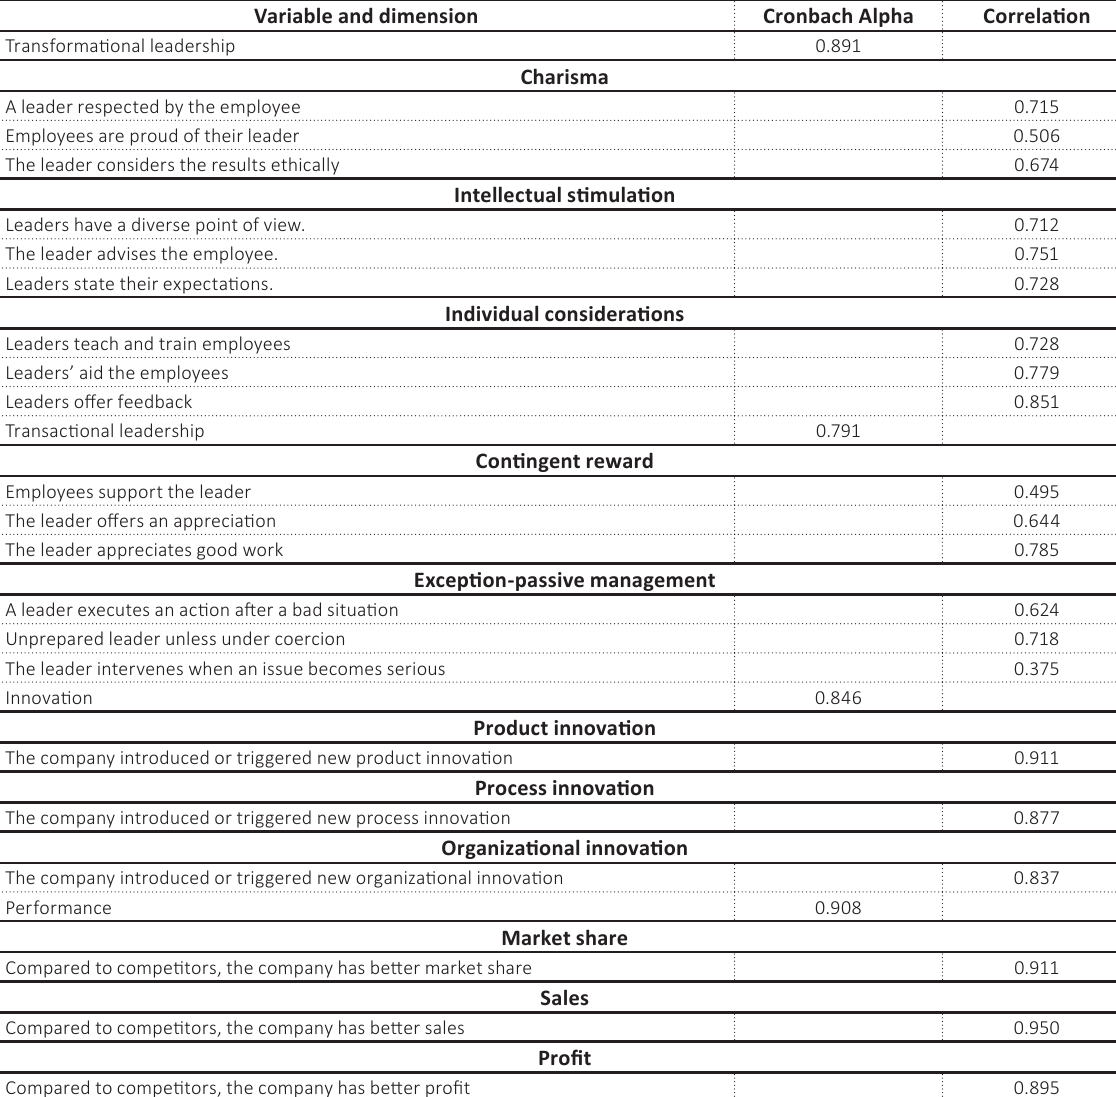
Table 1. The result of the validity and reliability